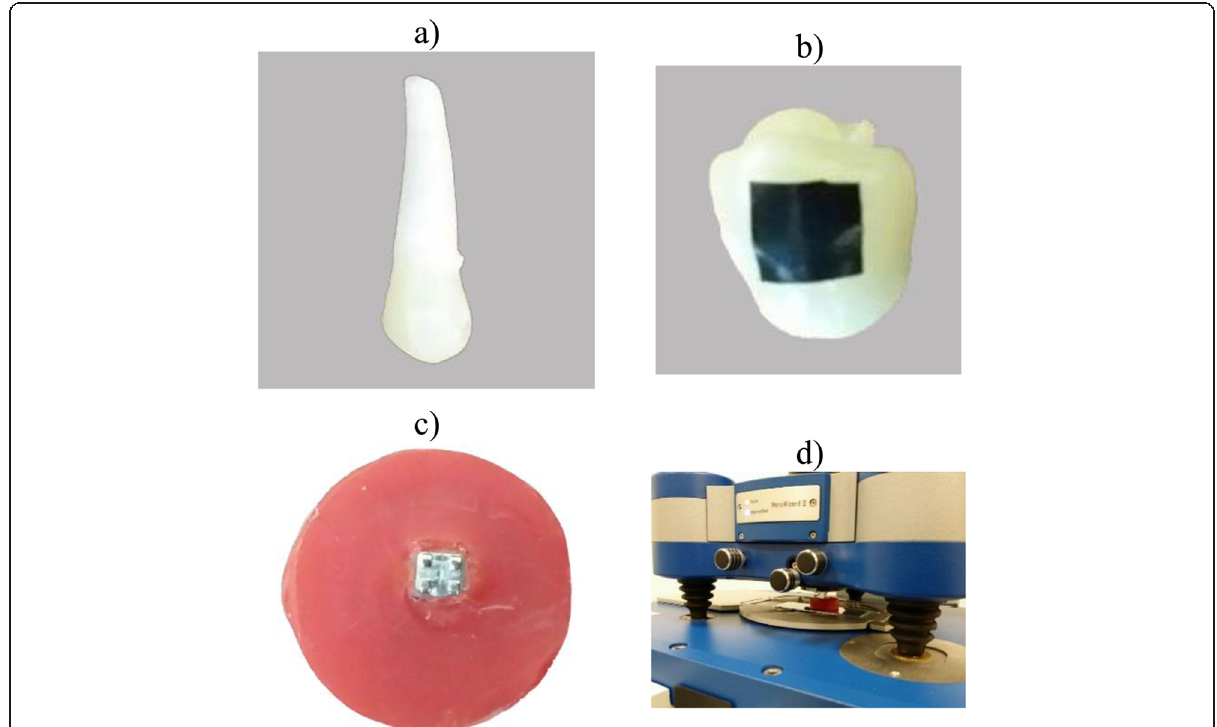
Fig. 1 Sample preparation and AFM analysis. A sample prior to preparation ( a ). A rectangular tape to protect the buccal surface before bracket bonding ( b ). A sample with a bonded bracket prior to debonding procedure ( c ). AFM analysis of the sample ( d